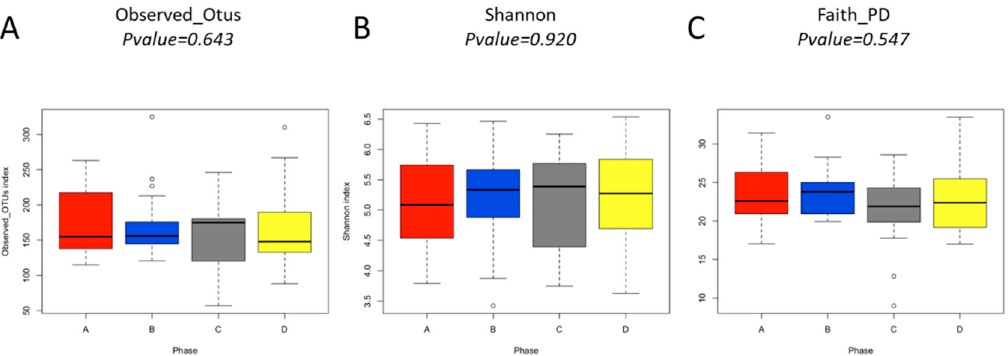
Figure 4. Results of the Alpha diversity analysis. ( A ) Observed Otus, ( B ) Shannon, and ( C ) Faith PD alpha diversity indexes for each phase of the study at a depth of 7393 sequences per sample. The p -value for each alpha diversity index was estimated using a Kruskal–Wallis test.